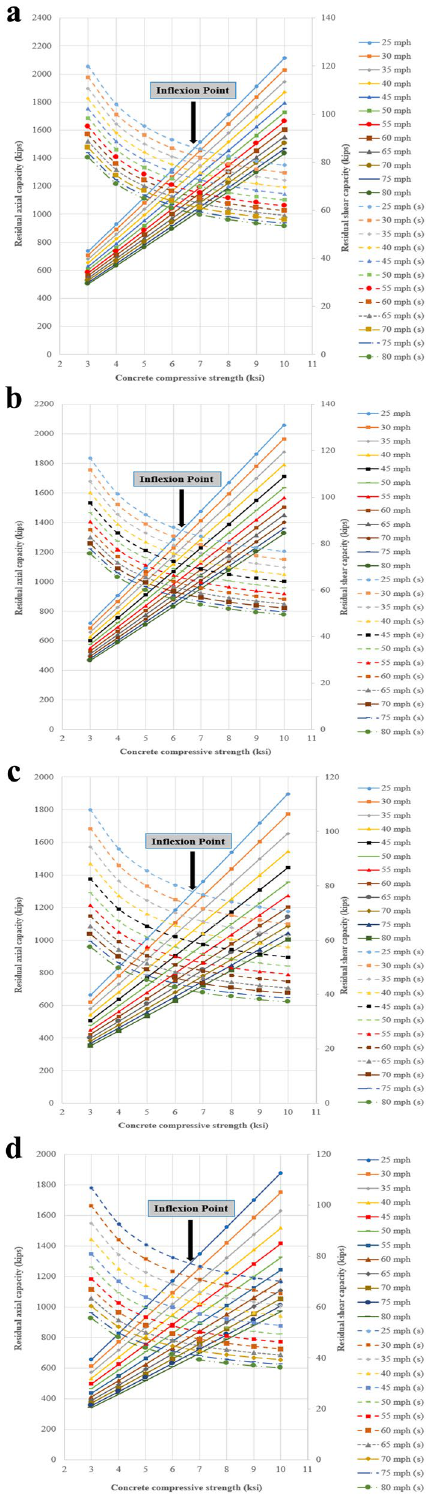
Fig. 7 a. Residual capacities showing inflexion points for Vehicle Class 5 using probability of failure (P f ). b. Residual capacities showing inflexion points for Vehicle Class 6 using probability of failure (P f ). c. Residual capacities showing inflexion points for Vehicle Class 7 using probability of failure (P f ). d. Residual capacities showing inflexion points Vehicle Class 8 using probability of failure (P f